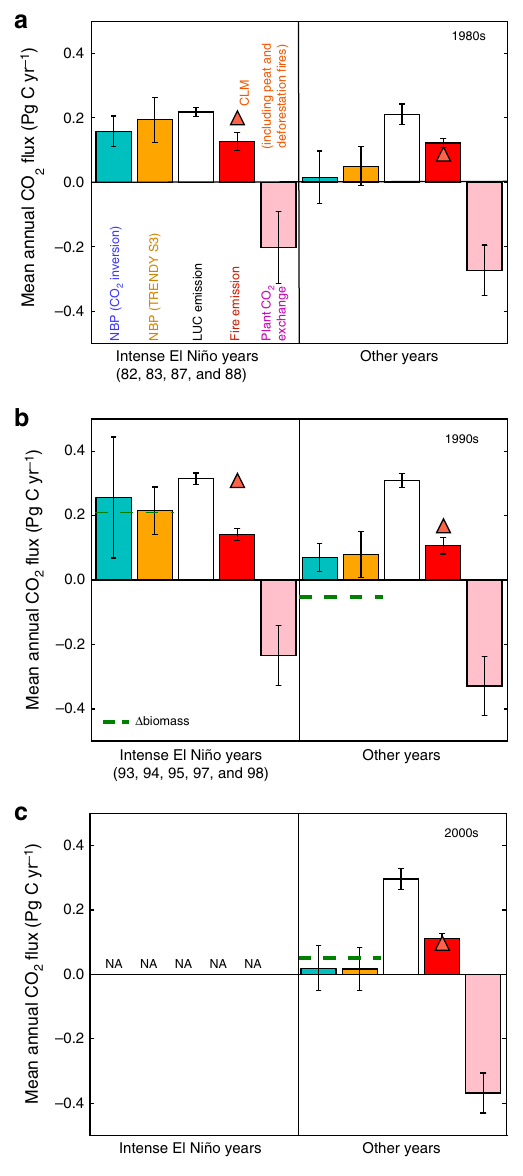
Fig. 4 In fl uence of the intense El Niño years on annual CO 2 fl uxes of the past three decades. Comparison of mean annual CO 2 fl uxes (NBP, LUC emissions, fi re emissions and plant CO 2 exchange) between the intense El Niño years and rest of years for a the 1980s, b the 1990s and c the 2000s. Mean annual NBP from the atmospheric CO 2 inversions (cyan) and TRENDY S3 (orange) are shown for the three decades, and Δ biomass (dashed green horizontal line) for the 1990s (1994 – 1999) and the 2000s (2000 – 2009). Component fl uxes such as LUC emissions (white) and fi re emissions (red), and plant CO 2 exchange (pink) are the estimates from the TRENDY S3. Fire emissions considering the attribution from peat and deforestation fi res (the CLM model; orange triangles) are shown separately from an ensemble average of fi re emissions by the other models. Error bars of each fl ux represent 1 σ variation among